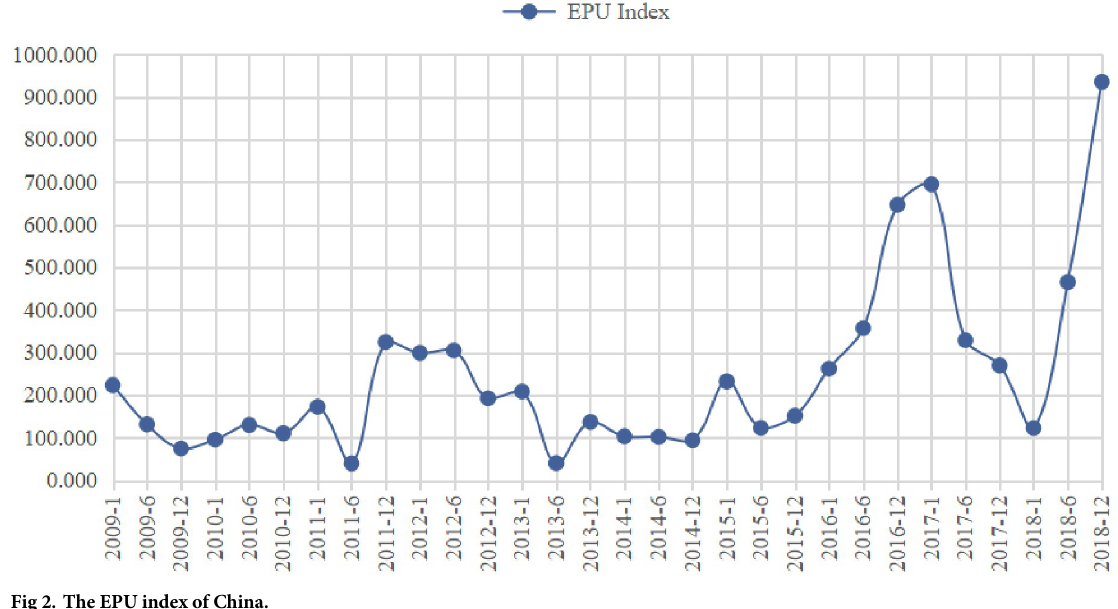
Fig 2. The EPU index of